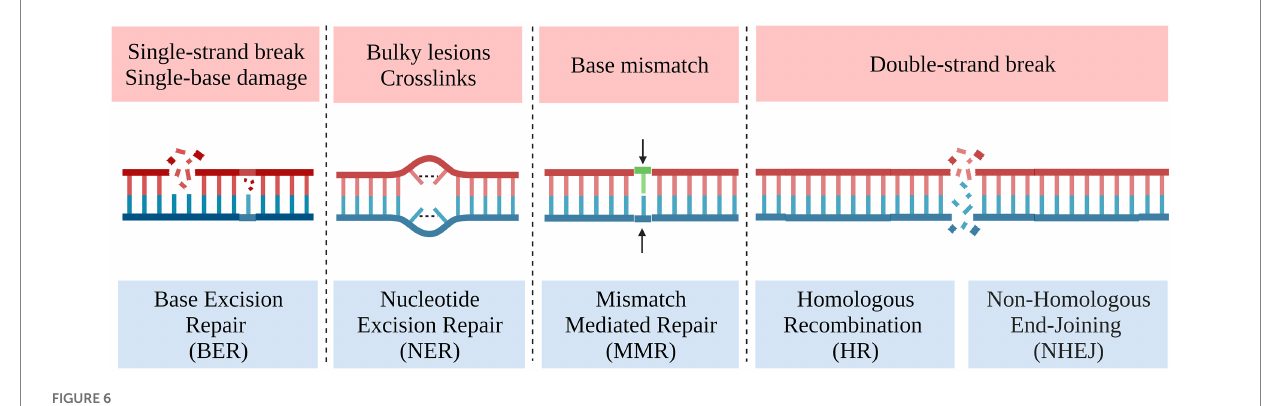
FIGURE 6 Different types of DNA damage and repair